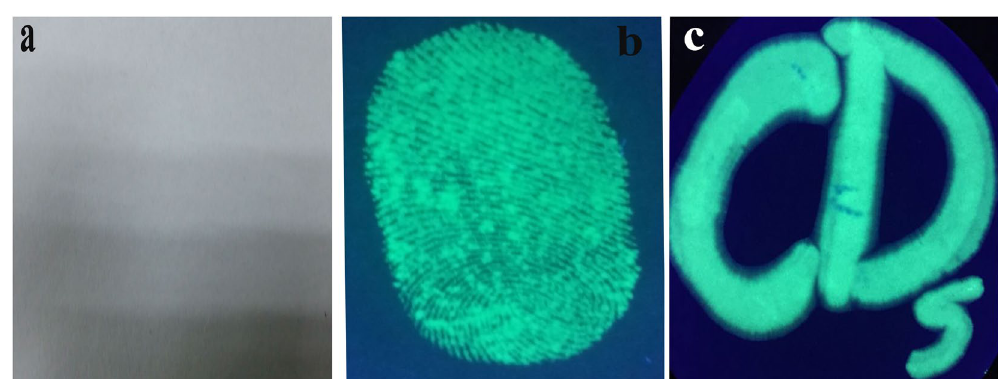
Figure 6. ( a ) Green-emitting CDs formed fingerprint under daylight ( b ) and 365 nm UV lamp irradiation. ( c ) Fluorescent characters on filter paper under UV